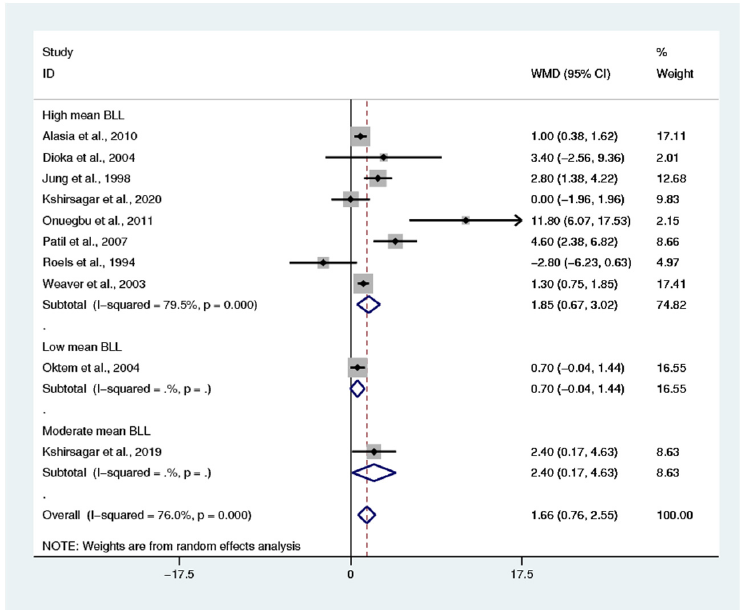
Figure 5. The mean difference in blood urea nitrogen (BUN) levels between exposed and non-exposed participants. WMD: Weighted Mean Difference (mg/dL), % Weighted: the impact proportion of each study to the pooled effect, CI: Confidence Interval (mg/dL), Black diamond symbol: point estimate for each study, White diamond symbol: pooled WMD in each subgroup or all groups, Solid line in the middle of the graph at 0: no difference in WMD between the two groups, Dashed line: pooled WMD between the two groups.